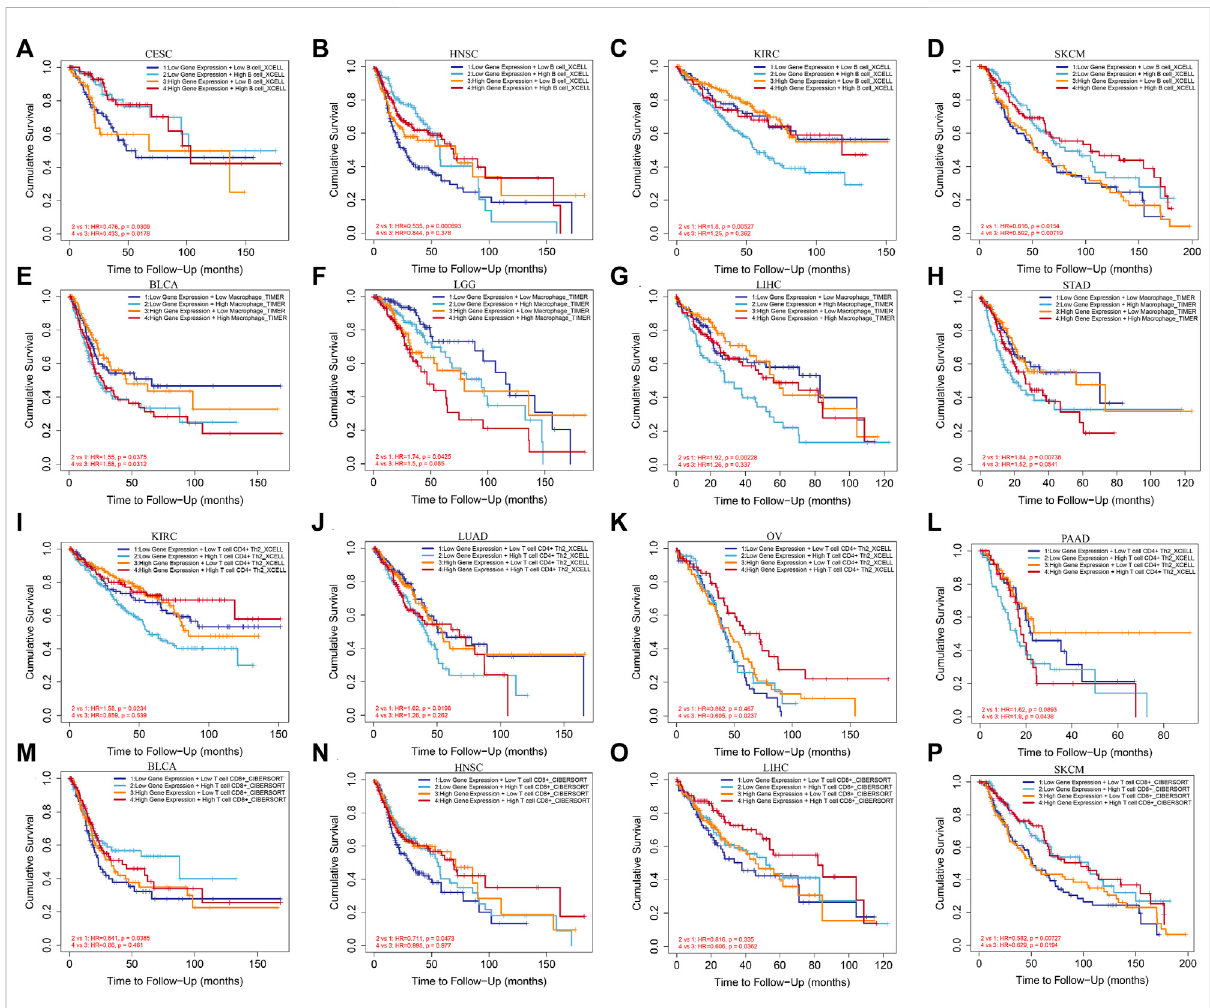
FIGURE 9 Theeffectofimmunecellsin fi ltrationonOSwasrelatedtotheexpressionofEXOC3L1. (A – D) EffectofBcellsin fi ltrationonOSofCESC,HNSC, KIRC and SKCM at different EXOC3L1 expression levels. (E – H) Effect of macrophages in fi ltration on OS of BLCA, LGG, LIHC and STAD at different EXOC3L1 expressionlevels. (I – L) EffectofTcellCD4 + expressiononOSofKIRC,LUAD,OV,andPAADatdifferentEXOC3L1 expression levels. (M – P) Effect of T cell CD8 + expression on OS of BLCA, HNSC, LIHC and SKCM at different EXOC3L1 expression